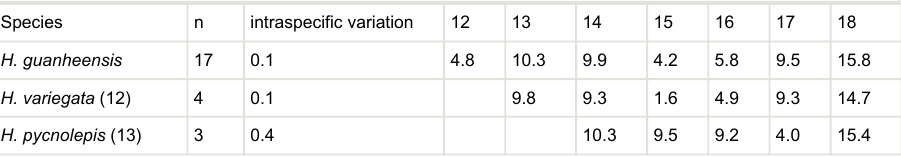
Pairwise comparisons of genetic distance of six Homatula species, based on K2P model from sequences of the Cyt b gene, the other annotations being the same as Table